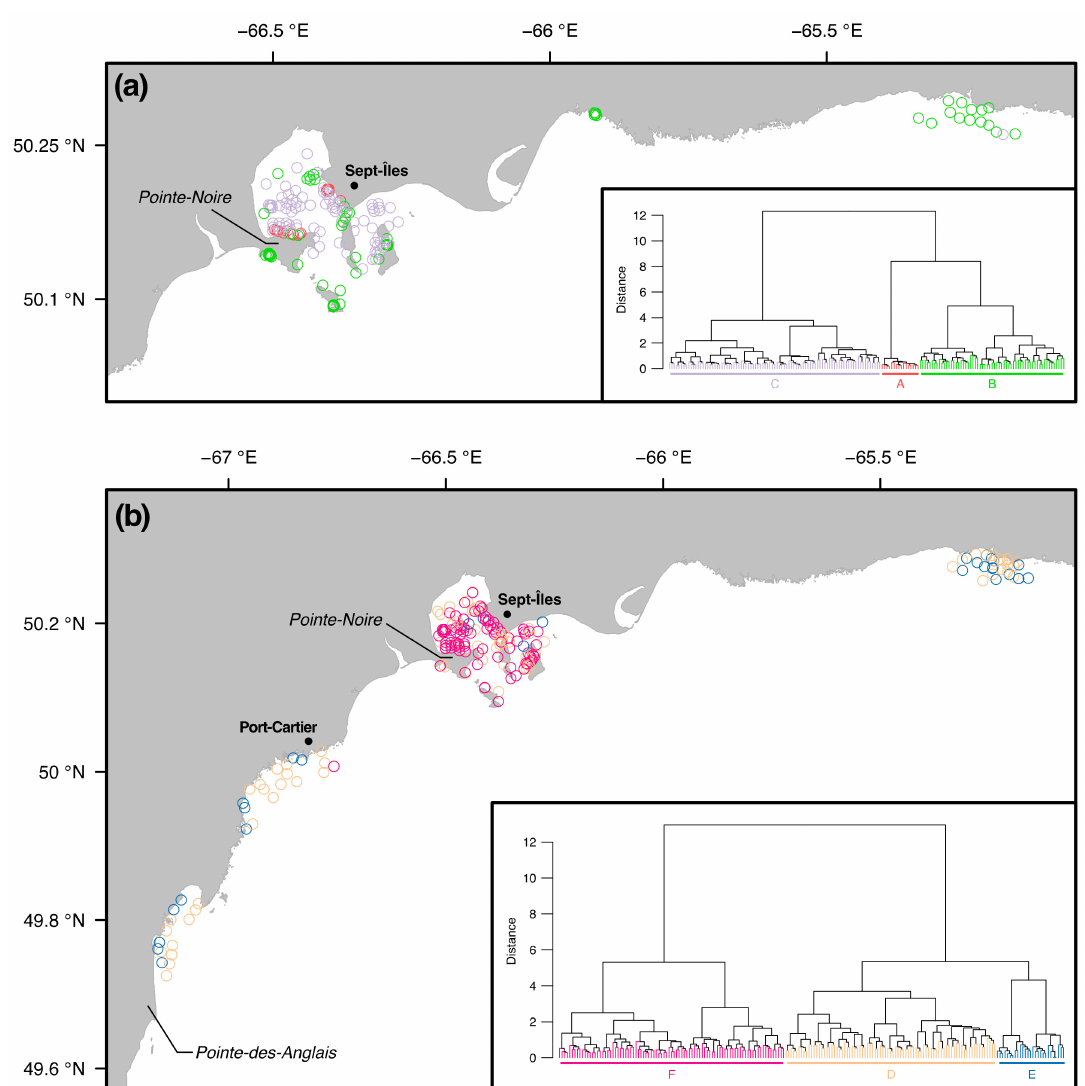
Figure 4. Hierarchical agglomerative clustering of taxa assemblages. The dendrogram presents relationships between stations, displayed on the map with one color for each group. ( a ) Clusters for the 0.5 mm size class; ( b ) Clusters for the 1 mm size